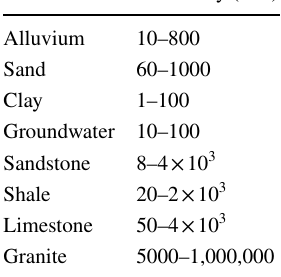
of common rocks and soil materials in survey area (Extracted from Loke